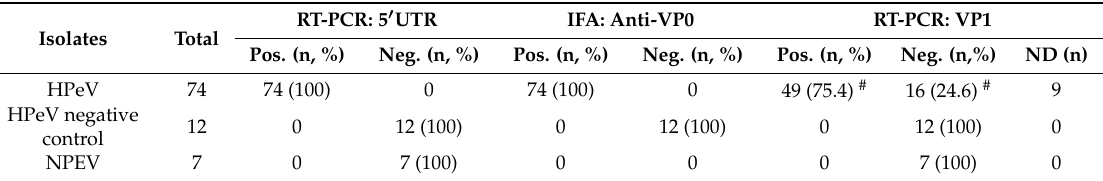
Table 1. The RT-PCR and immunofluorescence assay (IFA) results for human parechovirus (HPeV) detection.